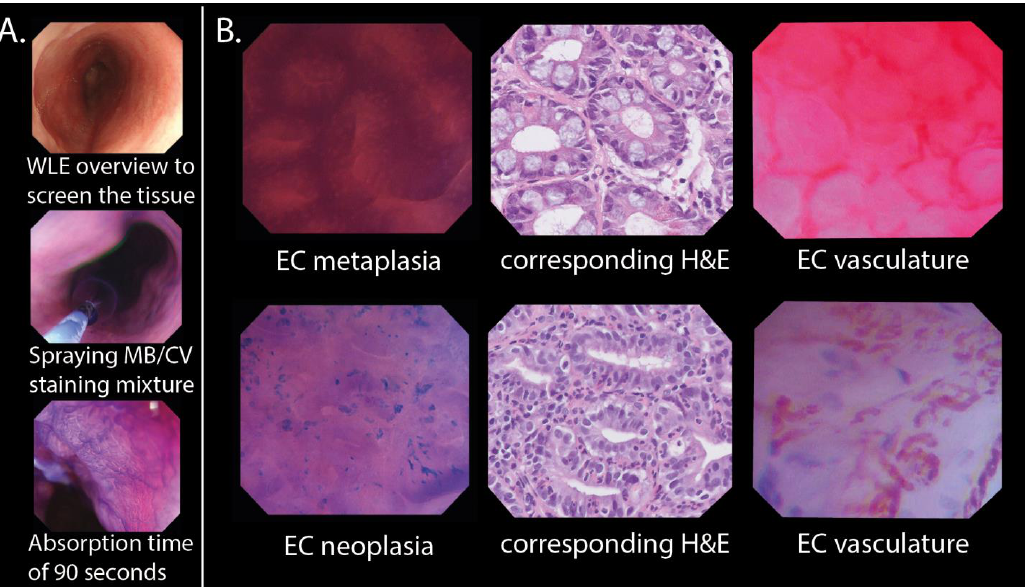
Figure 2. In vivo EC procedure and classification. ( A ) Sequential assessment of the BE performed during endoscopic examination using EC. ( B ) Examples of EC metaplasia and EC neoplasia with their corresponding histopathology. Examples of EC images showing microvascular features in metaplastic and neoplastic tissue are shown to the right. The EC metaplasia and EC neoplasia images were used to create endocytoscopic BE datasets. BE: Barrett’s oesophagus; CV: crystal violet; EC: endocytoscopy; H&E: haematoxylin and eosin staining; MB: methylene blue; WLE: white light endoscopy.